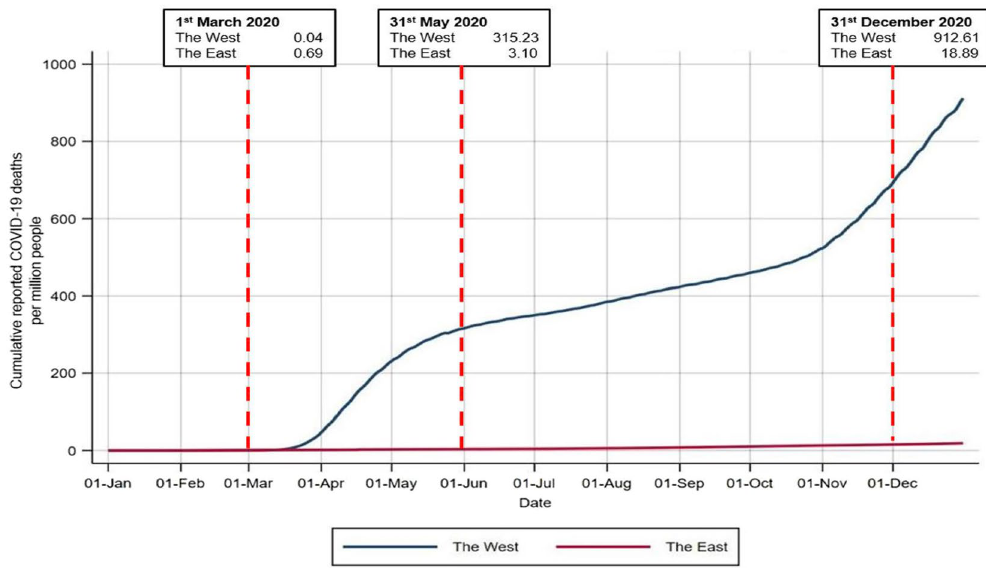
Figure 2. Trends in COVID-19 mortality (per 1 million people) in the West and in the East. Displayed mortality rates are unstandardized as data disaggregated by age groups are not available in any public repository. All countries displayed in this figure are those listed in Table S2 of the supplementary methods, including those < 1 million